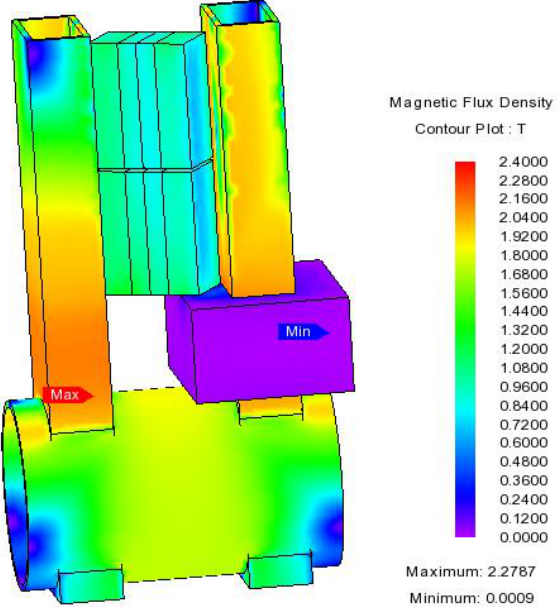
Figure 6. 3D magnetic flux density distribution in the LAT.